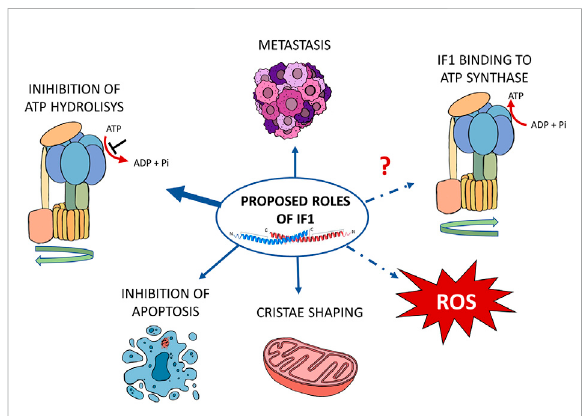
FIGURE 2 Schematic representation of the proposed functions of IF1 in cancer.Accordingtotheliterature,IF1affectscancerdevelopment through its effects on metastasis and cristae shaping, inhibition of ATPhydrolysisandofapoptosis.Apossible rolehasalso been proposed in the modulation of both ROS level and ATP synthase during oxidative phosphorylation. The proposed mechanisms are indicated by blue arrows. The IF1 roles that are still under investigation are indicated by the dashed